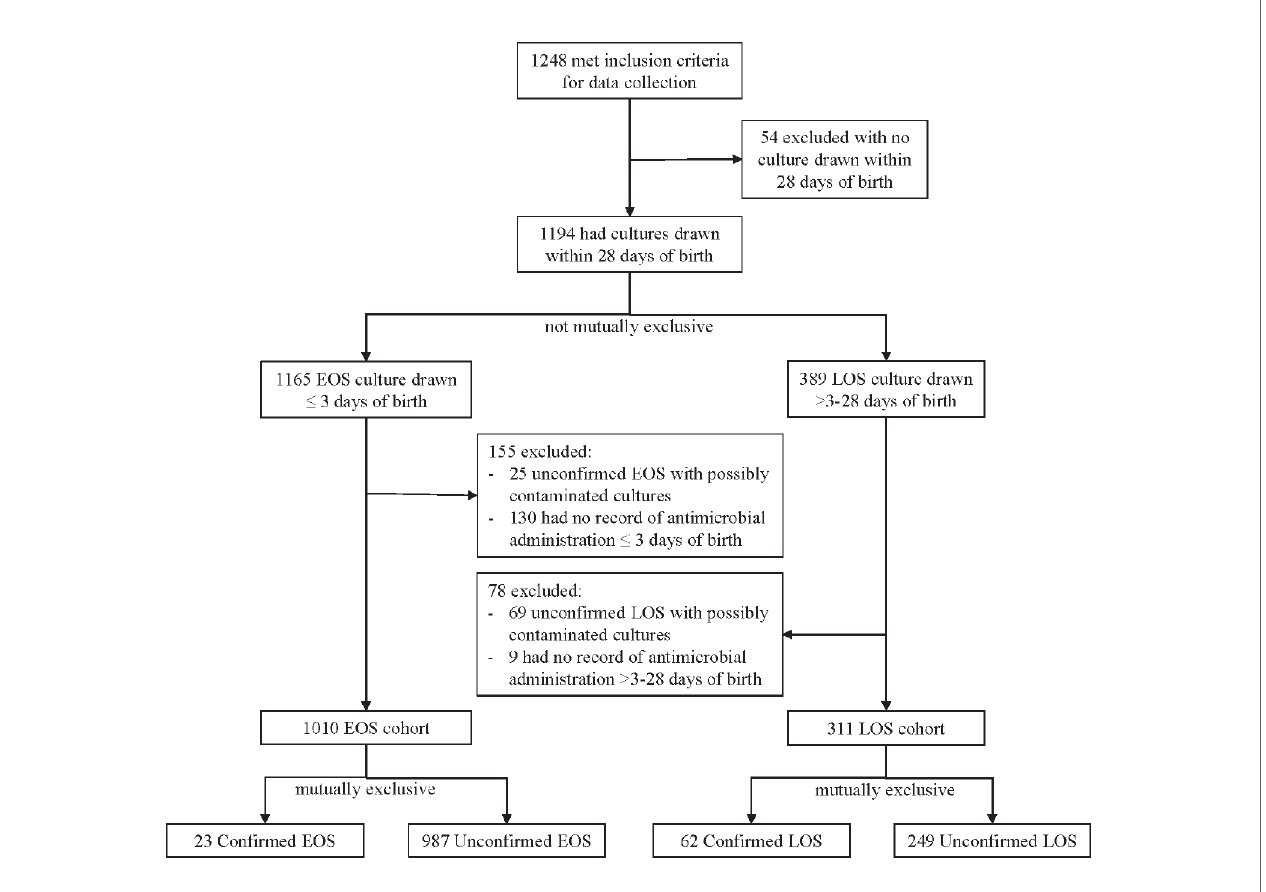
FIGURE 1 | Flow chart of study cohort